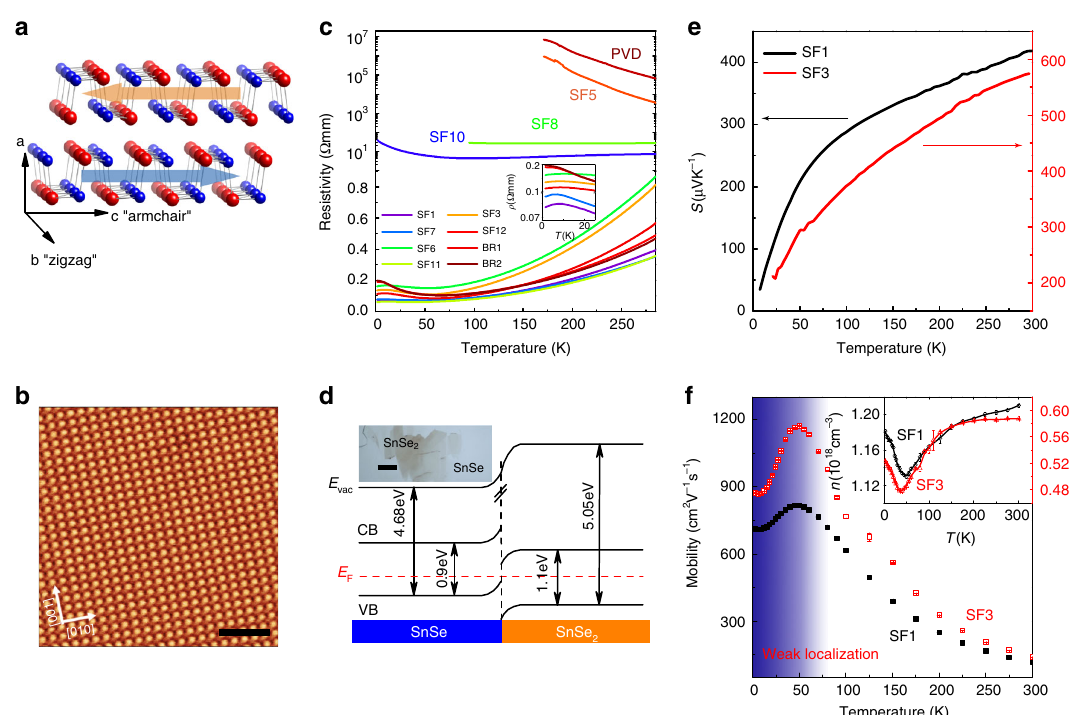
Fig. 1 Characterisation of SnSe single crystals. a SnSe crystallises into the BP-type puckered bilayer structure, by forming alternating Sn- and Se-rows along the b -axis. The binary lattice is highly polarised with a net ferroelectric dipole fi eld aligned with the c -axis. Here the red and blue balls represent Sn and Se atoms respectively. b Atomic-resolution nc-AFM image of stoichiometric SF1-SnSe, showing no existence of vacancies. The scale bar is 2 nm. c T - dependent ρ curves for all batches of crystals, showing various conduction behaviour from metallic (SF1, SF3, SF6, SF7, SF11, SF12, BR1, and BR2) to semiconducting (SF5, SF8, SF10, and PVD). Below 50 K, all metallic batches exhibit upturns in ρ vs T curves, a manifestation of WL. The inset zooms in the ρ vs T curves below 30 K. d Energy level alignment of SnSe/SnSe 2 heterostructure. Interfacial charge transfer leads to p-doping in SnSe. Note that the exact value of E F depends on both the concentration and thickness of SnSe 2 microdomains. The inset is a typical optical image of SnSe 2 microdomains on SnSe. The scale bar is 10 μ m. e High S b of SF1- and SF3-SnSe, which are in agreement with the literature reports. f T -dependent Hall measurements of SF1- and SF3-SnSe reveal mobility enhancement at low T , which is typical metallic behaviour. Note that the mobility drops below 50 K is due to